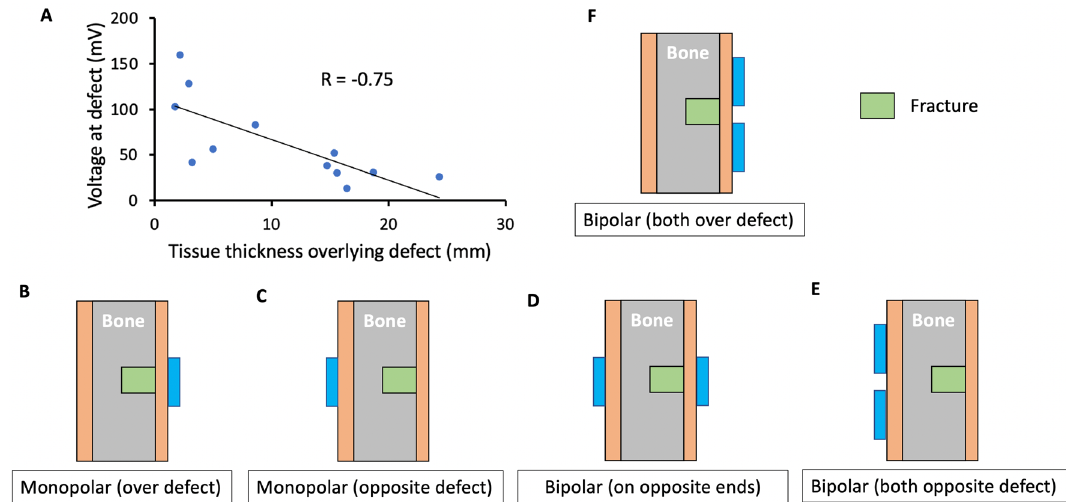
Figure 3. Results of noninvasive EBGS FEM models in sheep investigating stimulation electrode configurations. ( a ) Increased distance between the fracture defect and the stimulation electrodes is correlated to decreased voltage at the defect site during noninvasive EBGS therapy. This supports our hypothesis that EBGSs are critically limited in humans and large-animal models due to the weak electric fields reaching the fracture site. ( b ) Electric potential solution with stimulation electrode over defect site in monopolar configuration with distant return. ( c ) Electric potential solution with stimulation electrode opposite defect site in monopolar configuration with distant return. ( d ) Electric potential solution with stimulation electrodes in bipolar configuration: one over defect site and one opposite defect site. ( e ) Electric potential solution with stimulation electrodes in bipolar configuration: both opposite defect site. ( f ) Electric potential solution with stimulation electrodes in bipolar configuration: both over defect site. This configuration was used in all reported cadaver